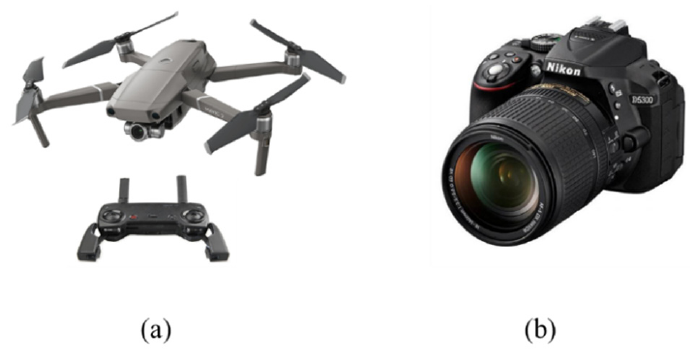
Figure 3. Experimental model: ( a ) bridge model; ( b ) plane model of bridge; ( c ) bolt connecting balls; ( d ) hollow round bar; ( e ) supports; ( f ) an excitation hammer.